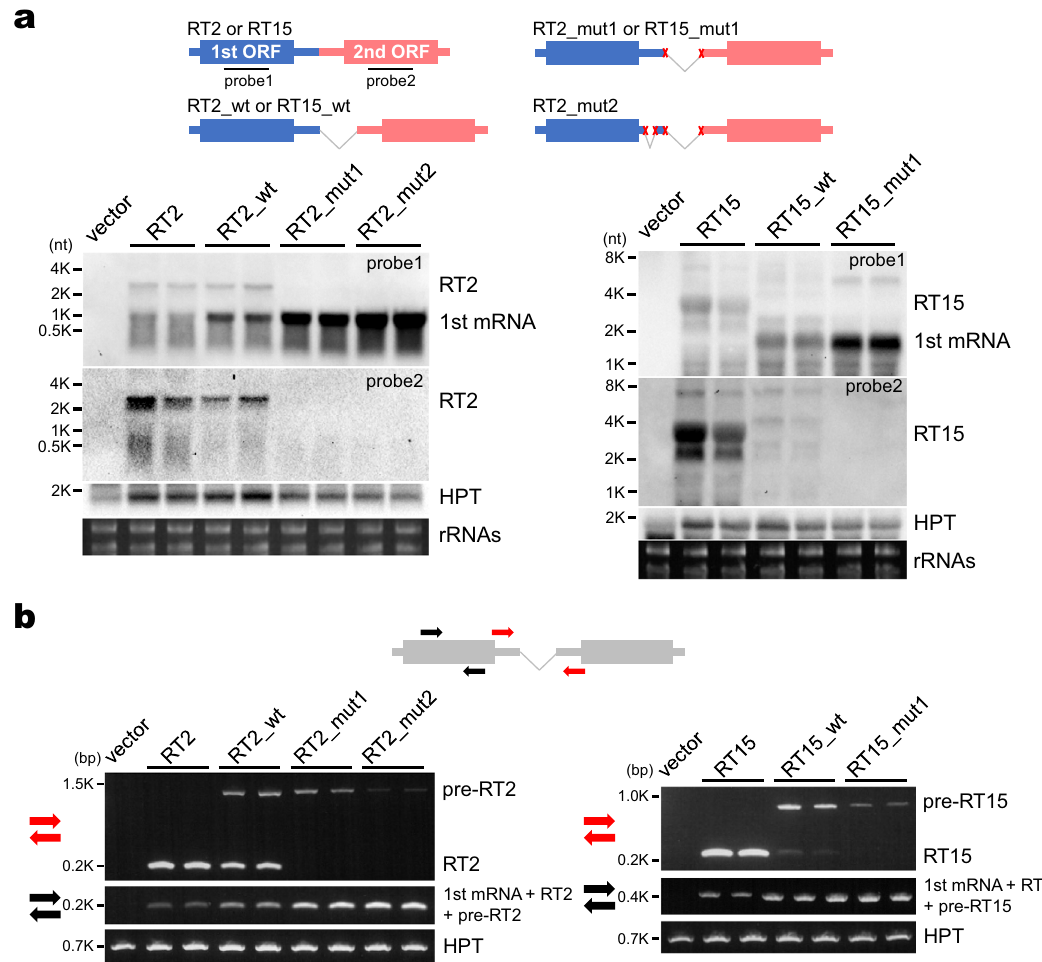
Fig. 5 Northern blot and RT-PCR analyses for RTs, pre-RTs, and pre-RTs with mutations at splicing sites by transient expression in Nicotiana benthamiana . a Northern blot analysis detecting mature RTs and mRNAs generated from the fi rst genes of the RT2 and RT15 loci. In RT2_mut1, the donor (GUA) and acceptor (CAG) sites of the major IS intron were replaced with CUC and GGG, respectively, and, in RT2_mut2, the donor (GUA) and acceptor (CAG) sites of both the major and minor introns were replaced with CUC and GGG, respectively. In RT15_mut1, the donor (GUA) and acceptor (AAG) sites were replaced with CUC and GGG, respectively. The upper illustrations indicate the transiently expressed RT cassettes. n = 2 biologically independent samples. b RT-PCR analysis for the detection of mature RTs and pre-RTs. The upper illustration indicates the positions of the two primer sets used. The red primer pair ampli fi es the pre-RT and mature RT separately, while the black primer pair redundantly ampli fi es the mRNA of the fi rst gene (1st mRNA), the mature RT and the pre-RT as a single band. n = 2 biologically independent samples. HPT = hygromycin Methods version 020201 44 . FPKM normalization was implemented with Cuf fl inks Plant and growth conditions . Wild type, upf1-1 10 and upf3-1 ( Arabidopsis ecotype v2.2.1 45 . ISO-seq data were processed using SMRT Link ver. 9.0.0 (PacBio) following Col-0) 9,40 were used in this research. Seed sterilization, sowing and growth con- their ISO-seq protocols with default parameters. First, consensus sequences were ditions in darkness and blue light have been described previously 4 , with the generated from subread data with ccs, then primer sequences and demultiplex were exception that the blue-light intensity here was 9 μ mol m − 2 s − 1 . removed with the Lima program. Quality control, clustering and polishing were performed with IsoSeq3 and the processed data were mapped to the TAIR10 CAGE, RNA-seq, ISO-seq, and Nanopore sequencing . The total RNA used for genome with pbmm2. BUSCO v5.1.3 and the eudicots_odb10 dataset 46 were used CAGE, RNA-seq, ISO-seq and Nanopore sequencing was extracted using Plant to estimate the completeness of the ISO-seq data. RNeasy Mini Kits (Qiagen) from 3-day-old seedlings grown under darkness and Nanopore reads were generated with EPI2ME Desktop Agent v3.4.2 (Oxford then irradiated with blue light for 3h. Library construction for CAGE and RNA- Nanopore) that analyzes the raw electrical signals into FAST5 fi les and converts seq was carried out using the CAGE Library Preparation Kit (DNAFORM) and them to FASTQ fi les. The raw sequences were mapped to the Arabidopsis genome TruSeq Stranded mRNA Preparation Kit (Illumina), respectively. The libraries (TAIR10) using minimap2 version 2.20-r1064-dirty 47 with the following (three replicates) were sequenced by HiSeq4000 or HiSeqX platforms. ISO-seq parameters: -ax splice -ub -k14 -G1000. The mapped data were sorted and libraries were constructed with the SMARTer ® PCR cDNA Synthesis Kit (Clon- tech) and SMRTbell Express Template Prep Kit 2.0 (Paci fi c Bioscience, Menlo Park, CA, USA) and sequenced by a PacBio Sequel II Platform. Nanopore libraries These next-generation sequencing data were visualized using JBrowse 1.16.11 48 . were constructed using PCR-cDNA Sequencing Kits (SQK-PCS109, Oxford Information on protein subcellular localization and chromosome distribution Nanopore) and sequenced by the MinION platform. were derived from the deposited data and tool in TAIR (https://www.arabidopsis. CAGE reads were mapped to the TAIR10 genome using both BWA v0.7.12 41 org/), respectively. and HISAT2 v2.0.5 42 . Merged mapped reads were counted with CAGEr software v1.16.0 43 and normalized with tags per million (TPM). Construction of plasmids for RT transient expression . Full-length RT sequences After removing low quality reads (QV < 20), RNA-seq data were mapped were arti fi cially synthesized by Euro fi ns Genomics K.K. (Tokyo, Japan) and onto The Arabidopsis Information Resource (TAIR) 10 genome with STAR